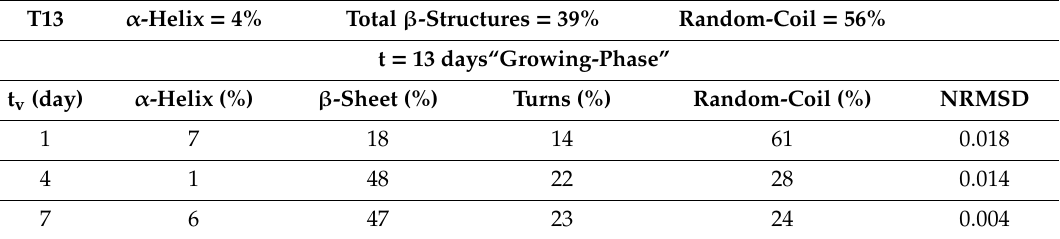
Table 3. Percentage of secondary structures obtained by the fitting procedure, relative to spectra of Figure 6.